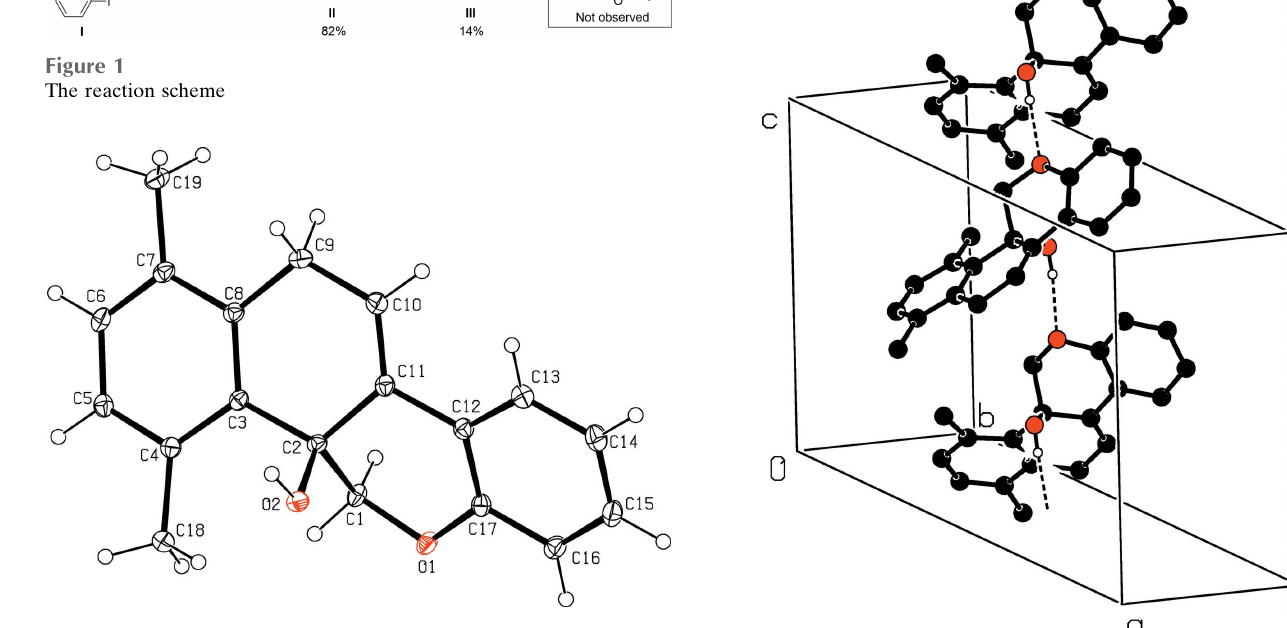
Figure 2 The molecular structure of the title compound with displacement ellipsoids drawn at the 30% probability